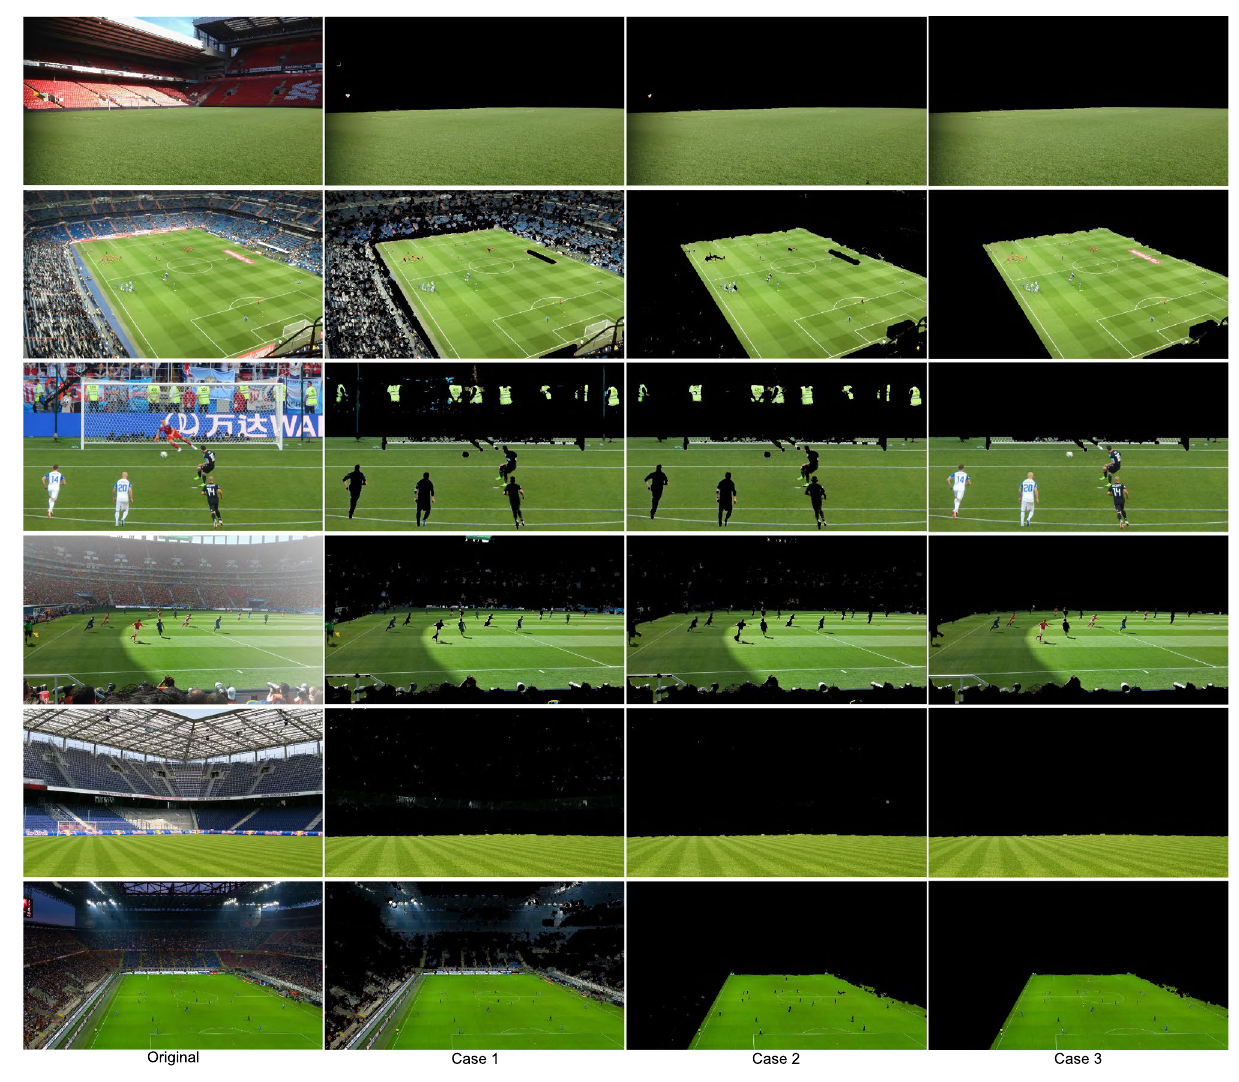
Figure 7. Some representative results obtained with the proposed strategy. Original images from 46 and 53